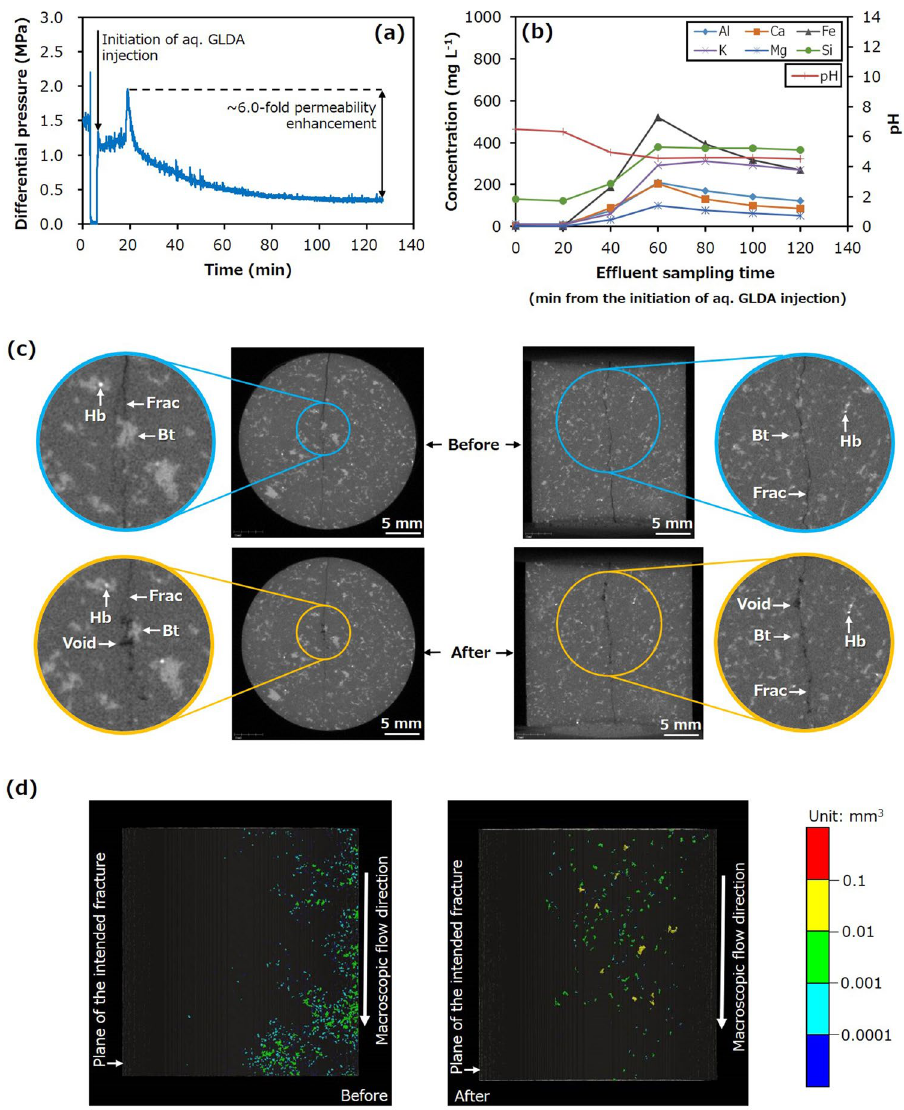
Figure 6. Hydraulic and chemical behaviours, and X-ray CT images for Run 4. ( a ) Differential pressure between the inlet and outlet as a function of time and ( b ) concentrations of various elements in the effluent and effluent pH as functions of time during Run 4. X-ray CT images displaying ( c ) the sample before and after the trial and ( d ) distributions of significantly large pores and fracture apertures before and after the trial ( Bt Biotite, Hb Hornblende, Frac